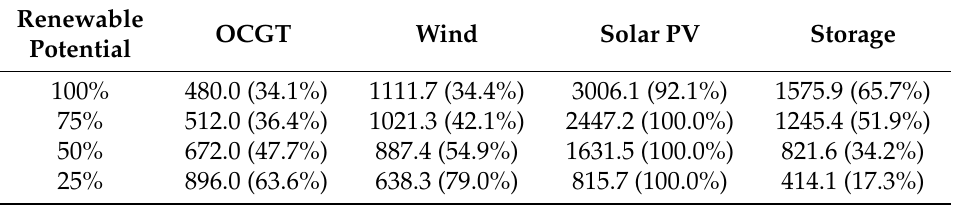
Table 20. Generation and storage capacity to be installed as a function of the renewable potentials